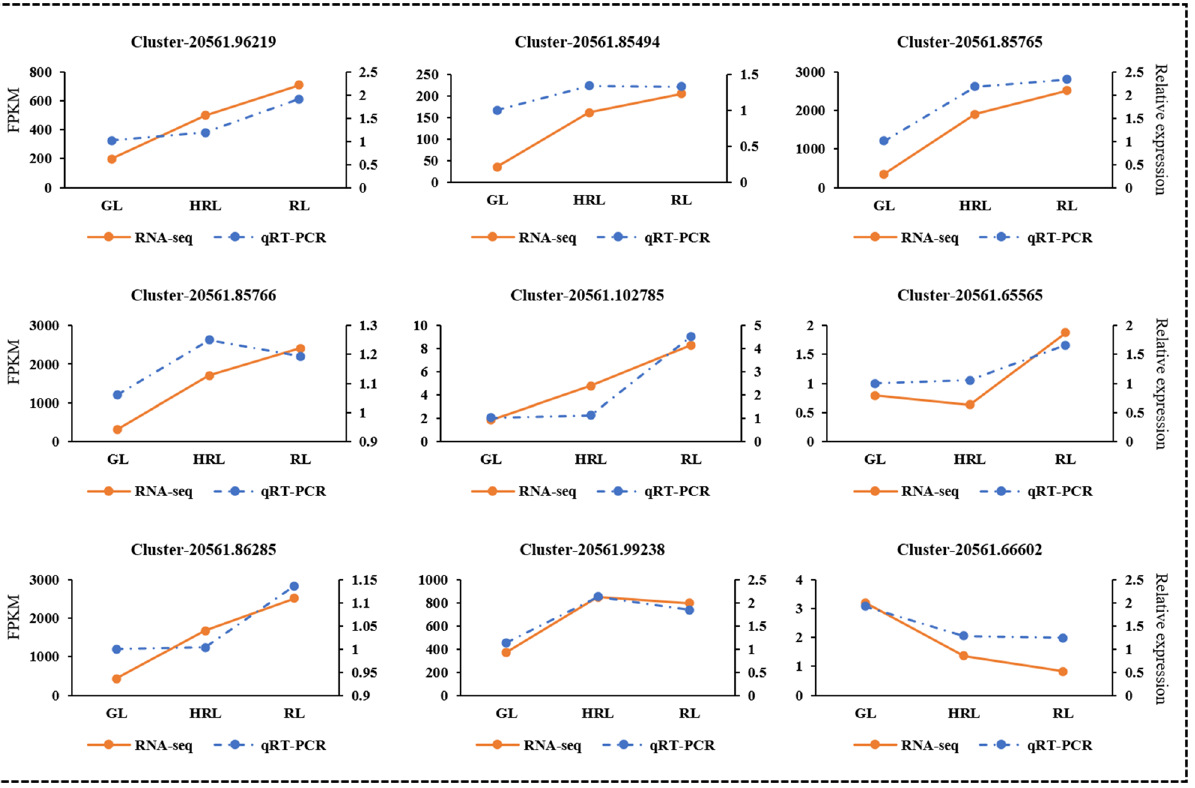
Figure 8. Verification of phenylpropanoid, flavonoid, and anthocyanidin biosynthesis-related differentially expressed genes (DEGs) by quantitative real-time polymerase chain reaction